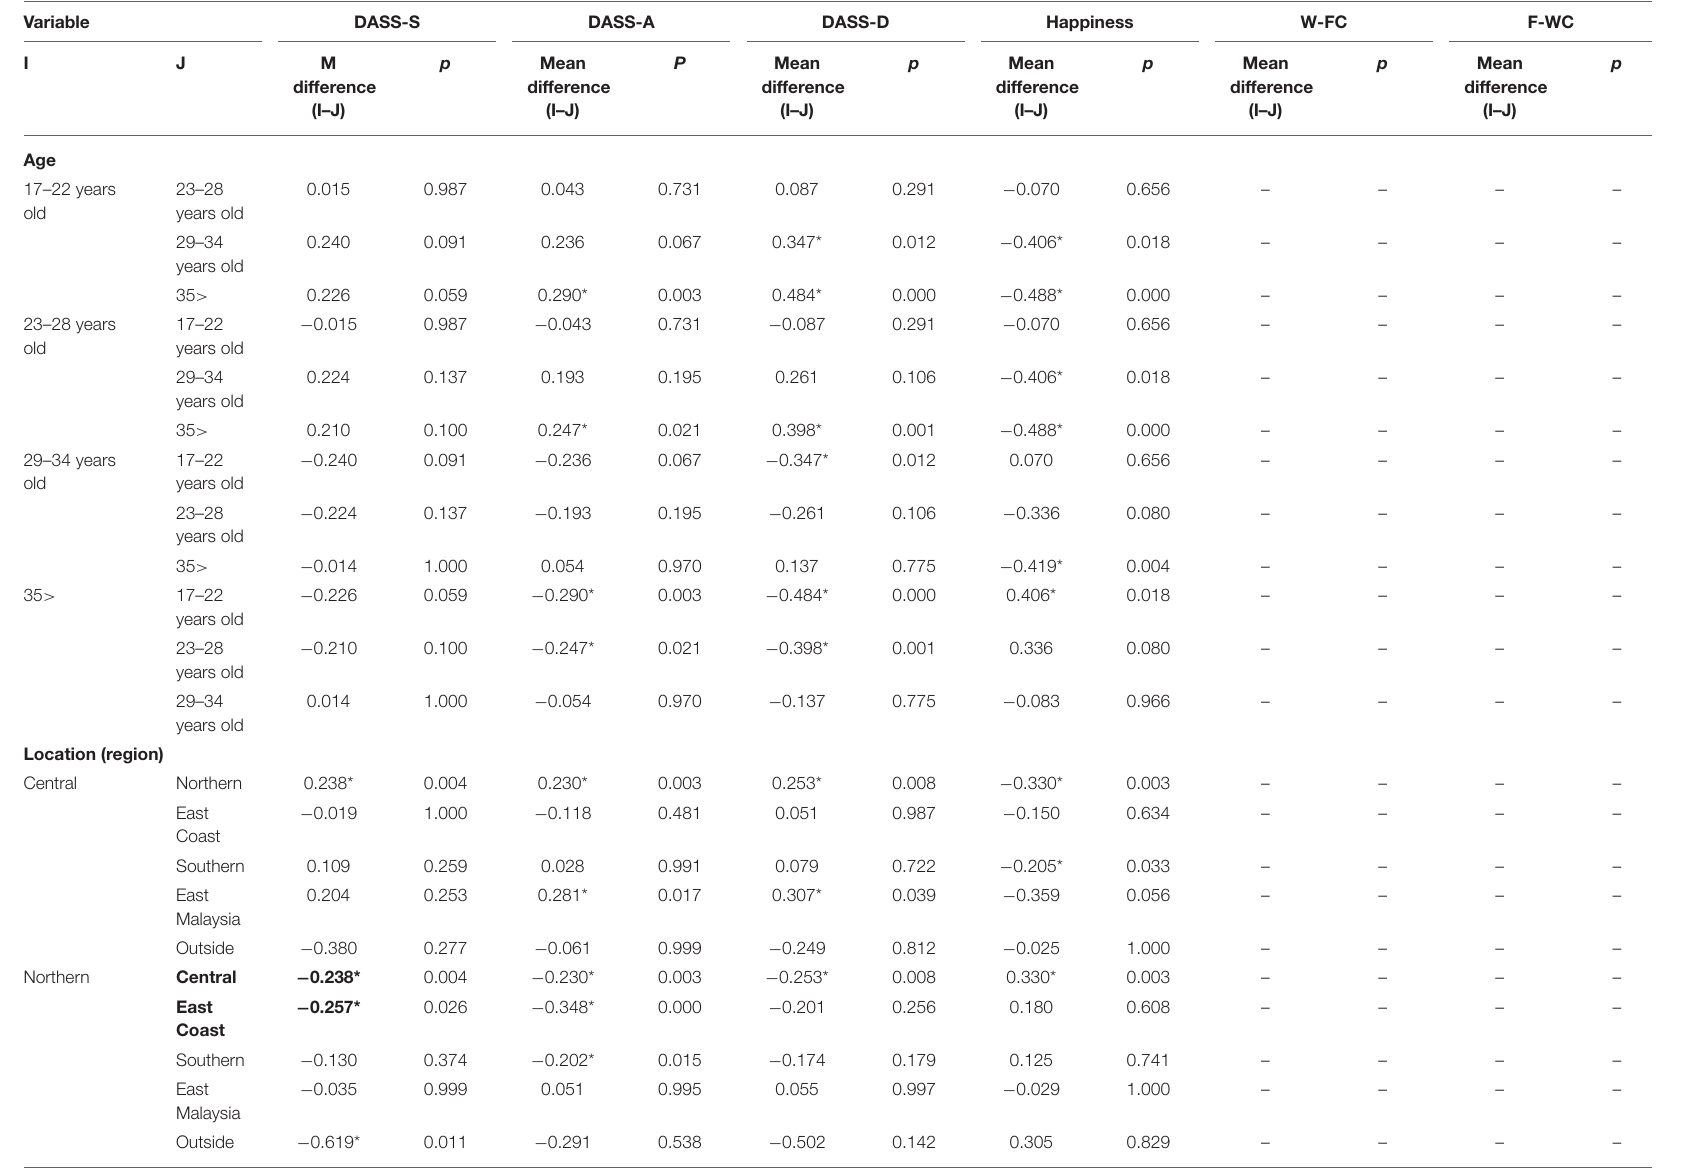
TABLE 6 | The results of post - hoc analyses ( n =